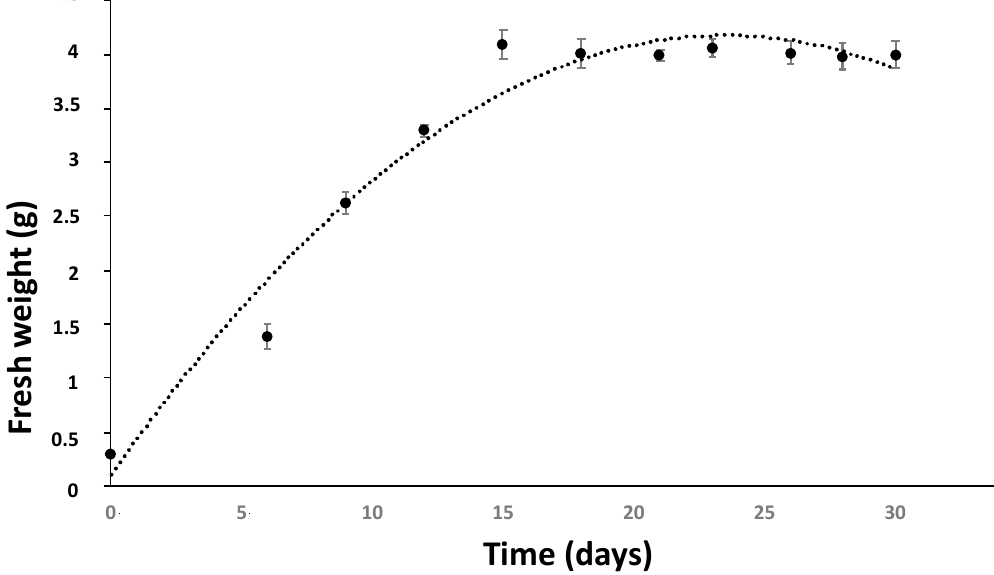
Figure 1. Growth kinetics of the hairy root line ‘Orchies 2659-31’ in 20 mL of liquid medium. 300 mg of roots from a 15 day-old hairy root culture were used as an inoculum and biomass production was recorded at different time points .